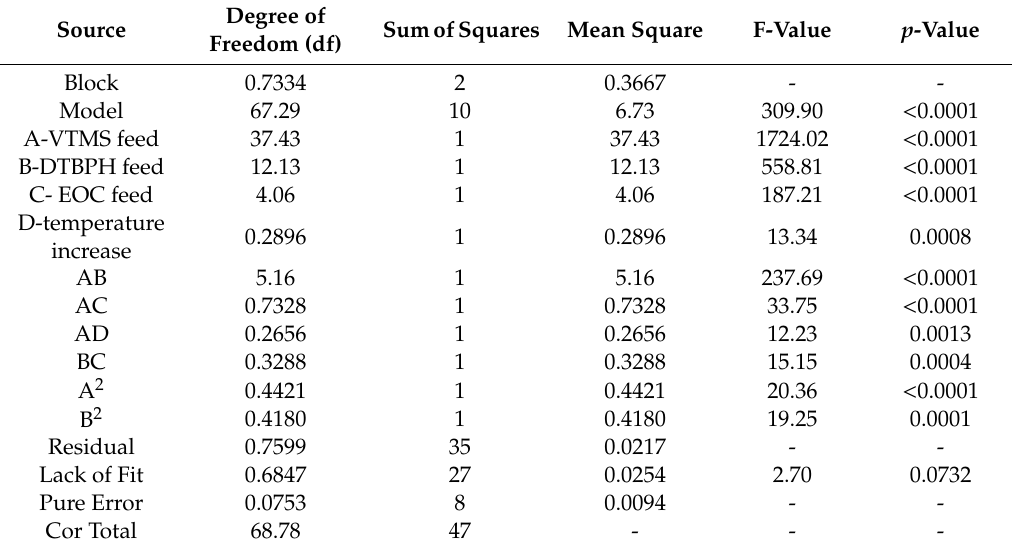
Table 4. ANOVA for response surface analysis of grafting